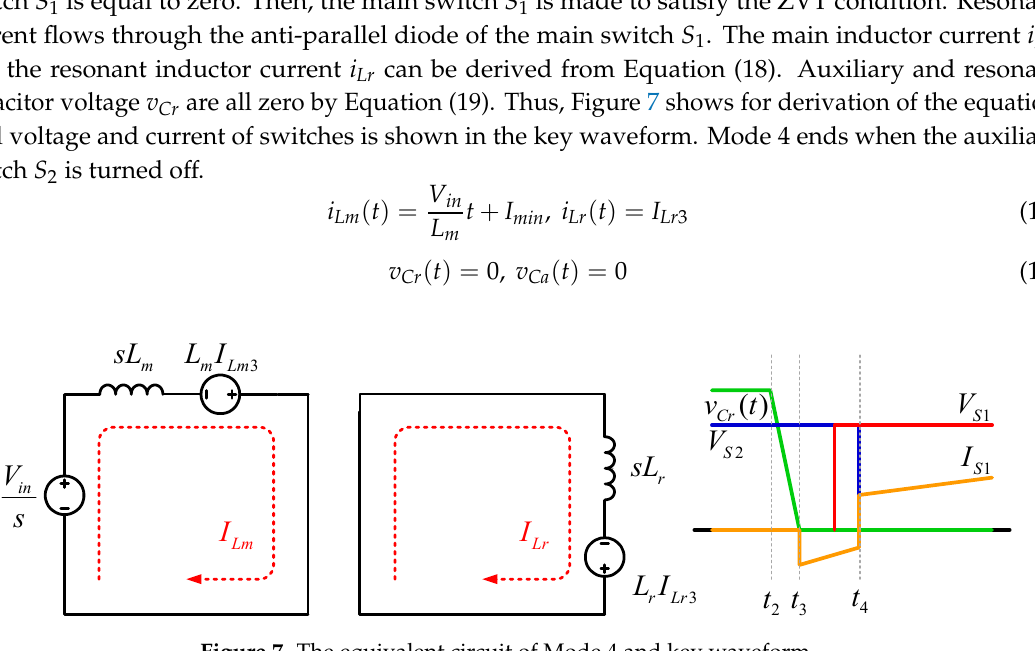
Figure 8. The equivalent circuit of Mode 5 and key waveform. Mode 5 ( t 4 < t < t 5 ): In Mode 5, the main switch S 1 is turned on under the ZVS condition. Then, the main inductor current i Lm increases linearly. The auxiliary switch S 2 is turned off in the same